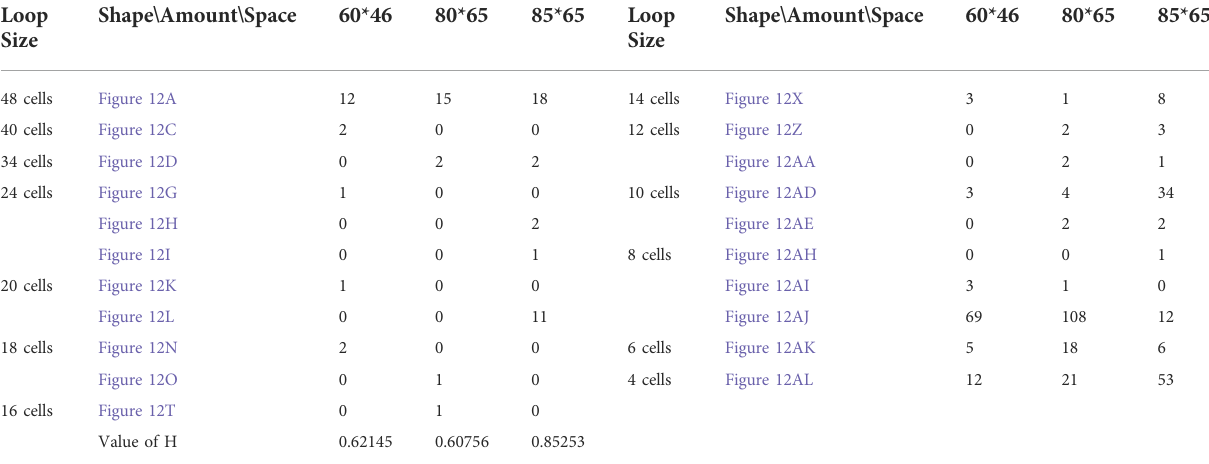
TABLE 15 Statistical numbers of the loops with various structures for the adding mechanism on different cellular spaces starting from the initial con fi guration in Figure 7E. Loop